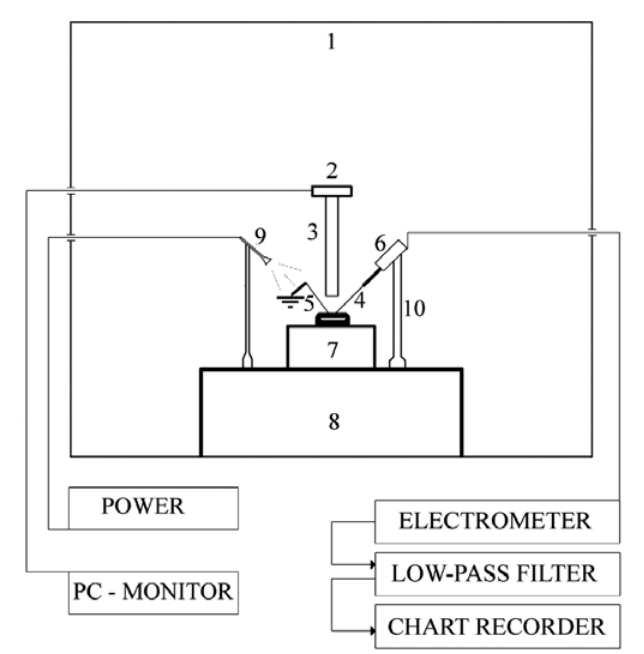
Fig. 1 Schematic electrophysiological set-up for membrane potential measurements. 1. Faraday cage. 2. Digital cameras. 3. Micro- scope tube. 4. Measuring microelectrode. 5. Reference elec- trode. 6. Probe. 7. Microscope stage. 8. Vibration-free table. 9. Lamp. 10. Micromanipulator.